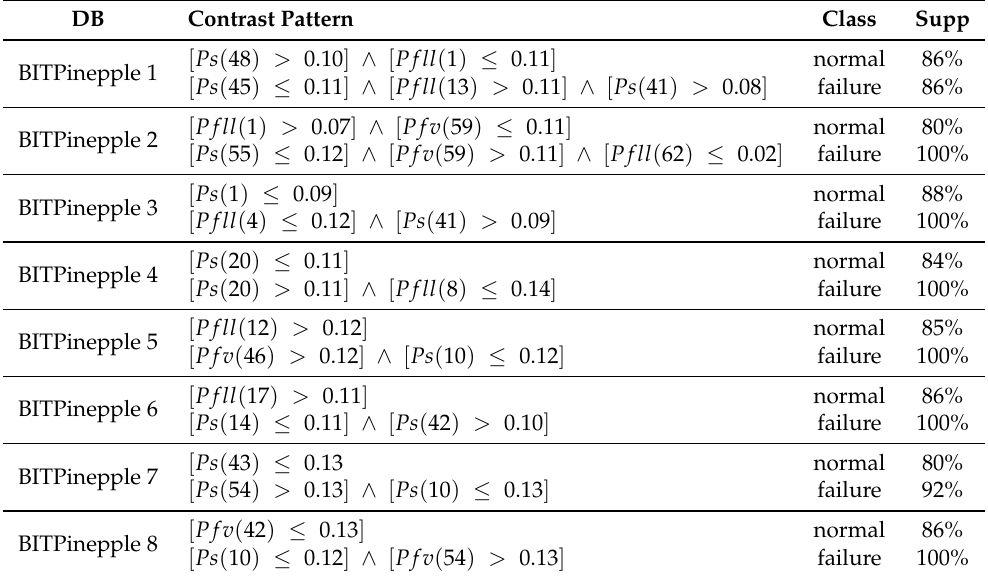
Table 6. Examples of contrast patterns extracted from the databases proposed in [6] by using PBC4cip.